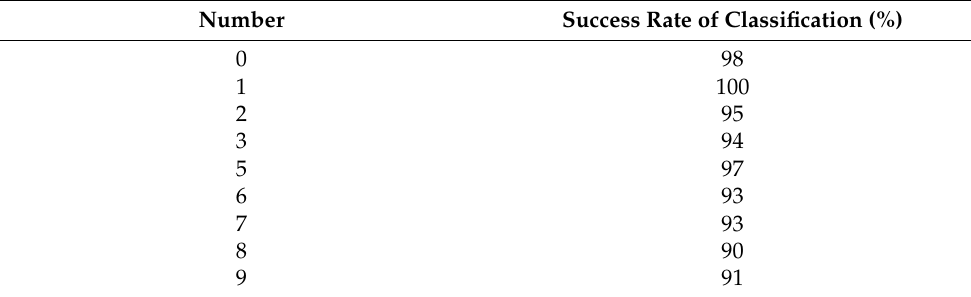
Table 3. Classification success rate of (cid:100) 4 (cid:99) and other numbers.